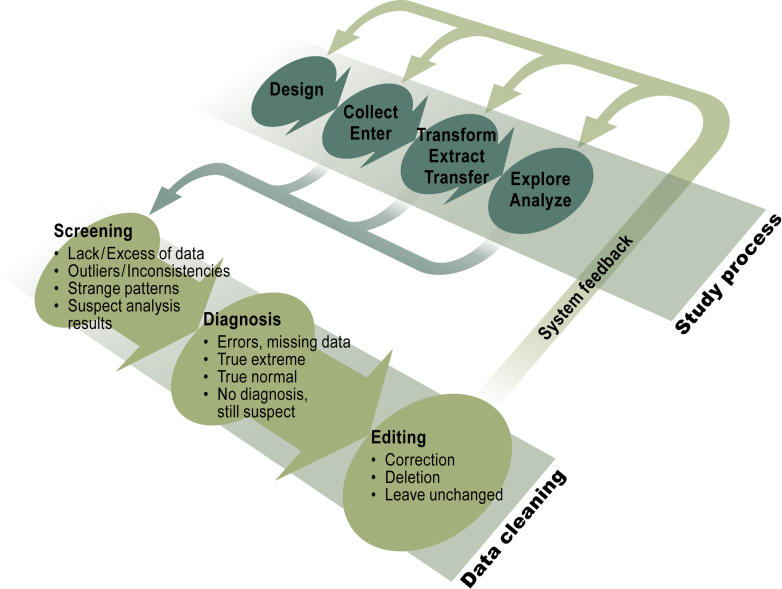
A Data-Cleaning Framework(Illustration: Giovanni Maki)